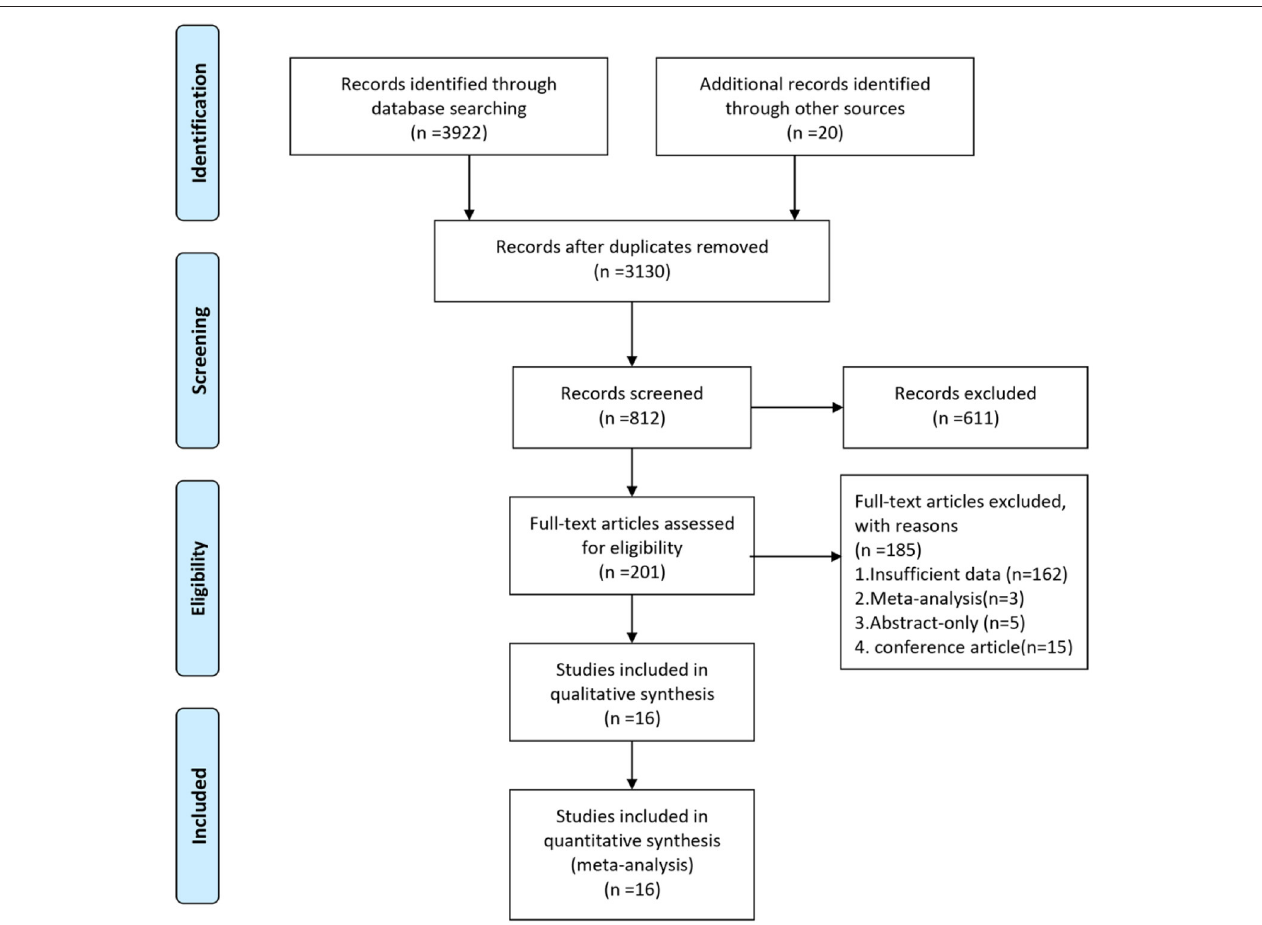
FIGURE 1 | PRISMA flowchart of included